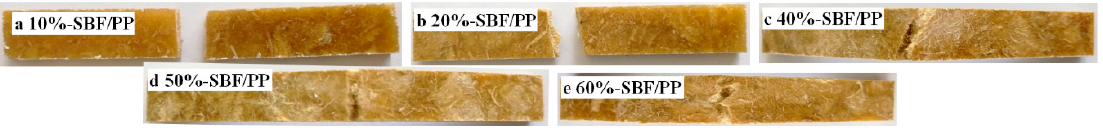
Figure 4. Impact strength of the composites and pure PP: ( a ) the un-notched charpy and ( b ) notched charpy of PP; ( c ) image of the PP after the impact test. Figure 5. Photograph of the composites after the impact test. ( a – e ) belong to the composites with 10%– 60% SBF, respectively.